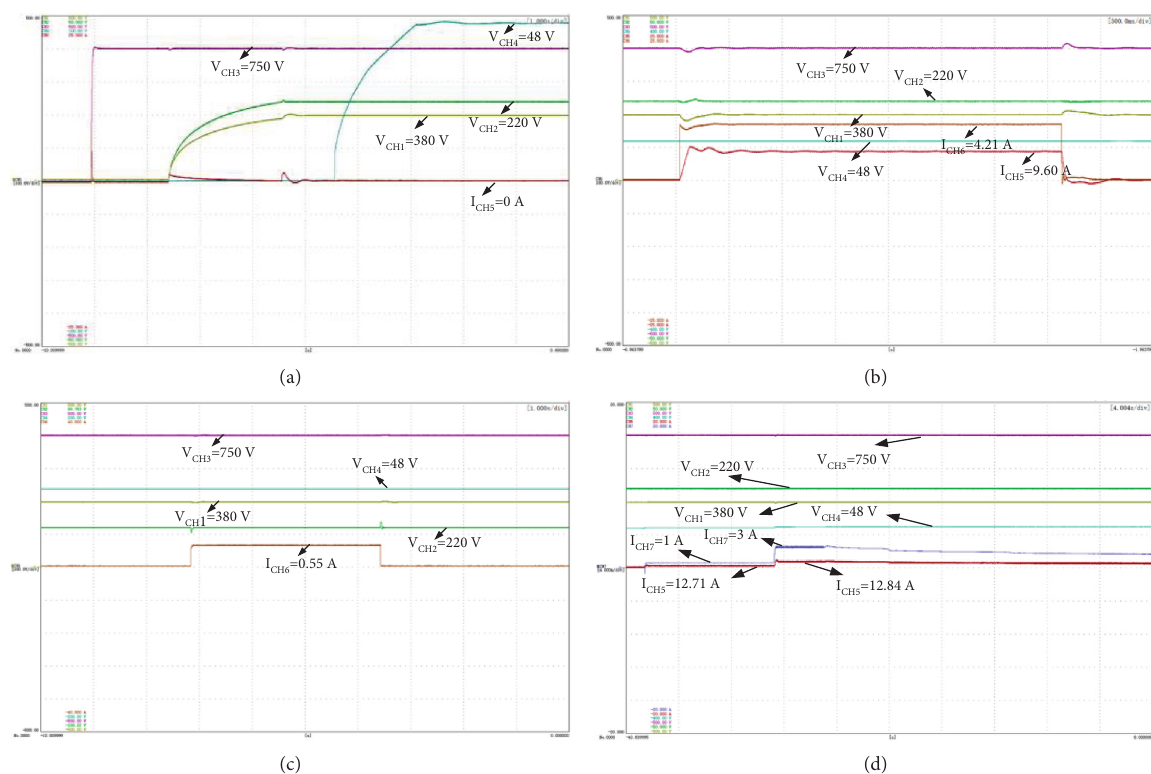
Figure 20: Experimental waveforms in different modes. (a) Start-up process. (b) Status switching of 380V port. (c) Status switching of 220V port. (d) Status switching of ESS